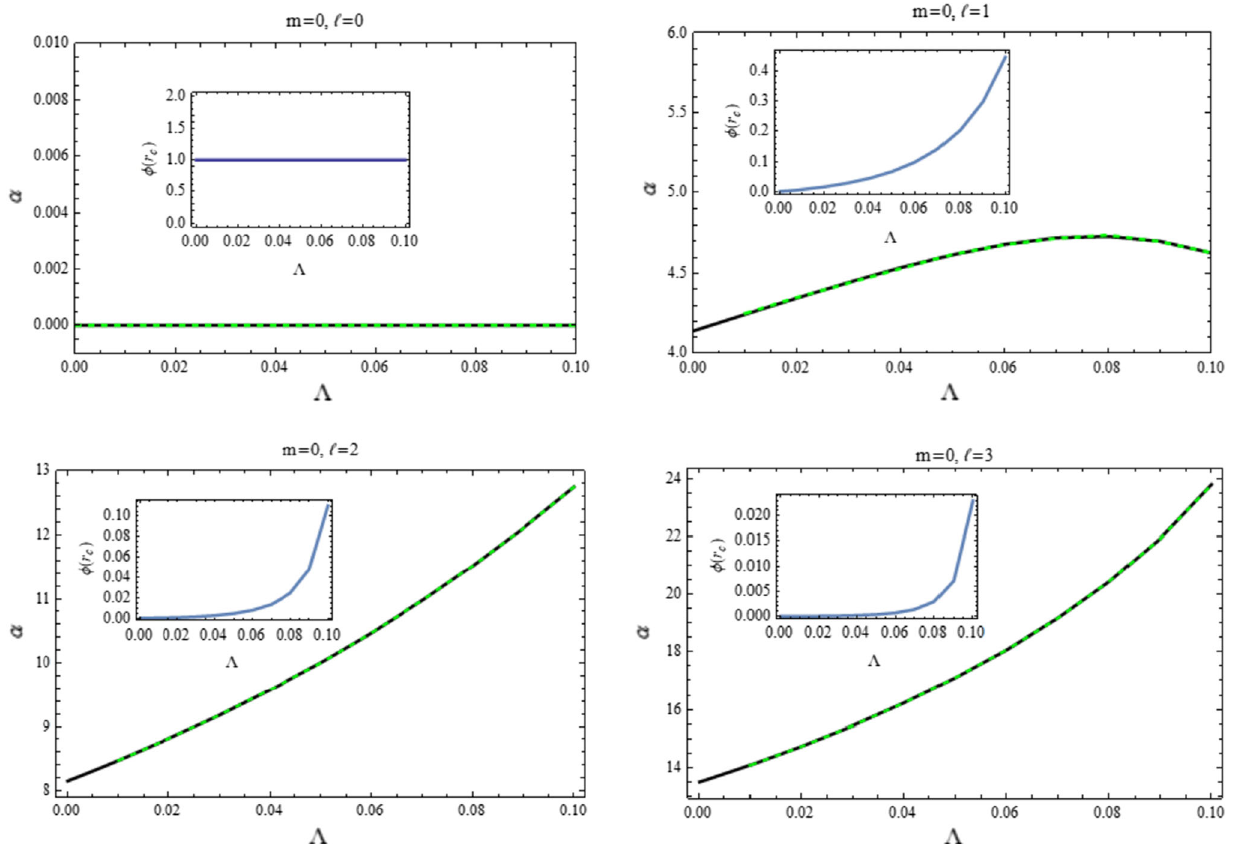
Fig. 12 The coupling parameter against the cosmological constant for the critical SdS black hole that admits a spherical massless scalar could with the lowest state with k = 0 for various modes, and the insets exhibit the corresponding values of scalar field at r c . Here we have set M = 1 and φ( r e ) =